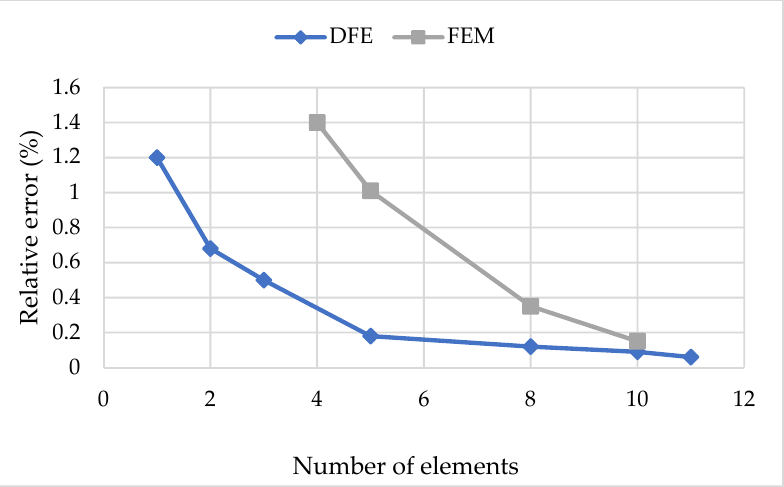
Figure 3. The convergence study for the two proposed LBFEM and LBDFE formulations; relative error of fundamental frequency for cantilevered FML three-layer beam subjected to an axial load of 17.5 MN and end moment of 52.5 KN·m.